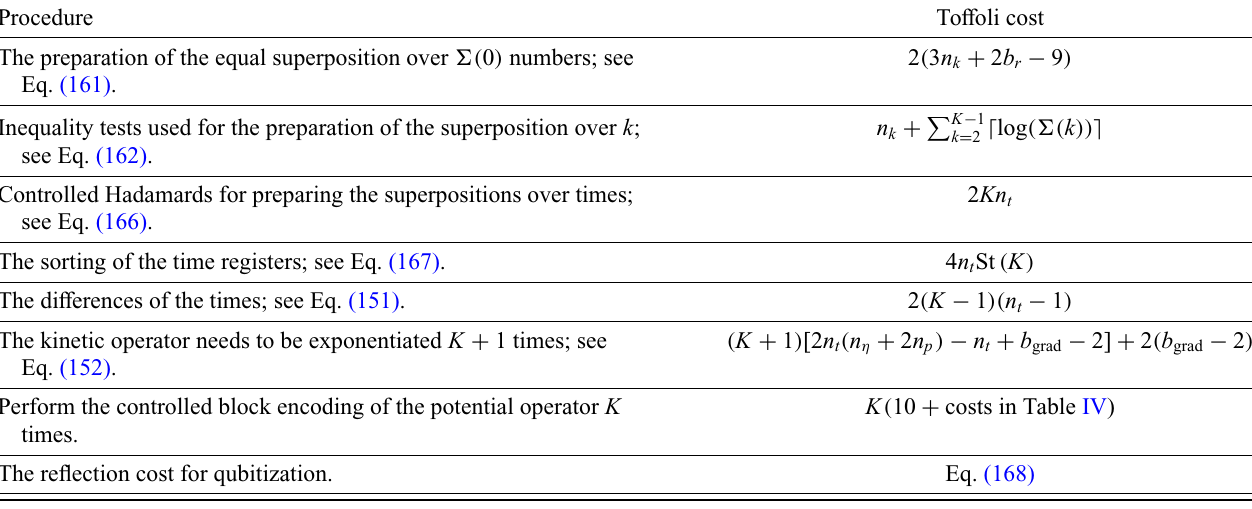
2 ( 3 n k + 2 b r − 9 )